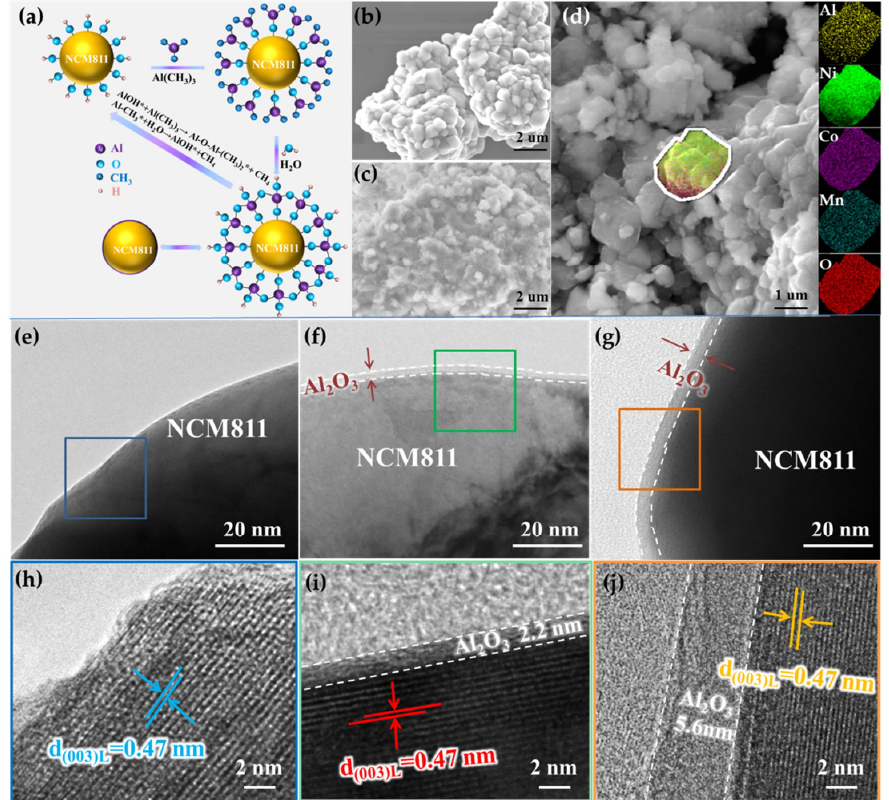
Figure 1. ( a ) Schematics illustration of the Al 2 O 3 ALD growth at the surface of NCM811 particles; FESEM images of ( b ) bare NCM811, and ( c ) 20 Al 2 O 3 ALD NCM811; EDS mapping of ( d ) 20 Al 2 O 3 ALD NCM811; TEM images of ( e ) bare NCM811, ( f ) 20 Al 2 O 3 ALD NCM811, and ( g ) 50 Al 2 O 3